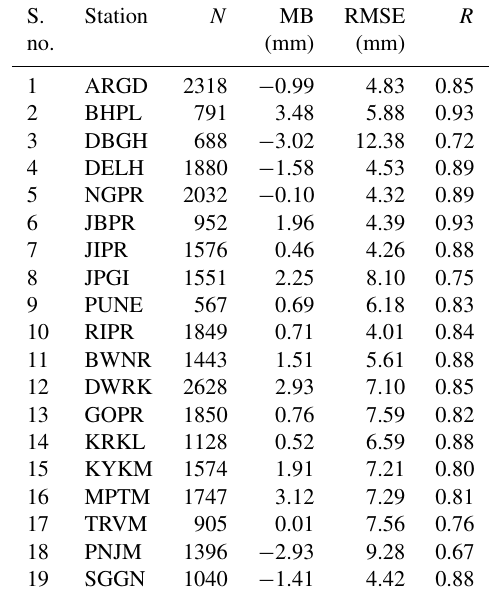
Table 3. Statistical analysis of IPWV retrievals from INSAT-3DR and GNSS data (January 2017 and June